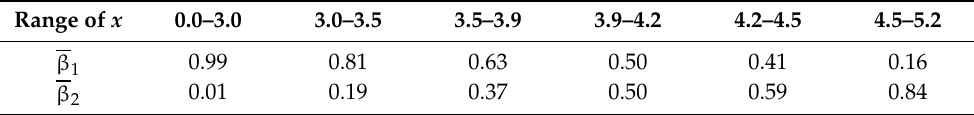
Table 2. Mean values of β 1 and β 2 for the six groups of x = Log(T T ) within District 9. Range of